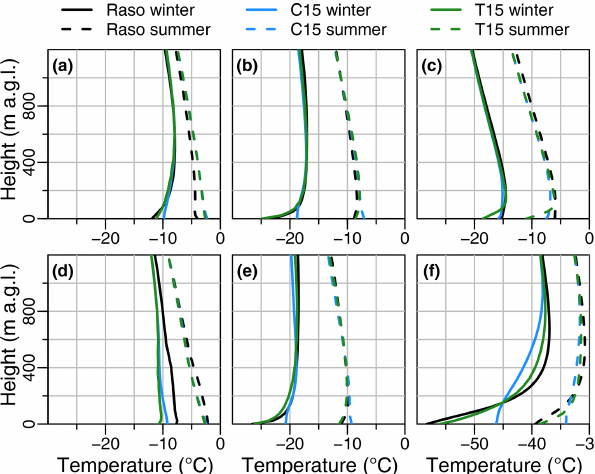
Figure 11. Mean temperature of radio sounding (Raso; black), C15 (blue), and T15 (green) during winter (solid line) and during sum- mer (dashed line) for the stations (a) Marambio, (b) Neumayer, (c) Novolazarevskaya, (d) Rothera , (e) Halley, and (f) Amundsen– Scott. Note the different range on the x axis for (f) Amundsen– Scott. The abbreviation a.g.l. is short for “above ground level”, meaning above the